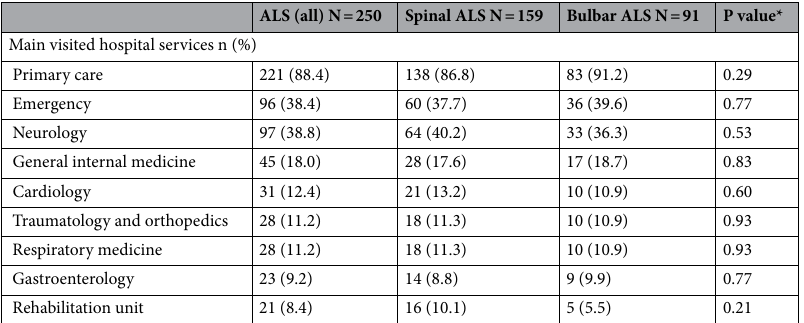
Table 2. Visited hospital departments and prior to ALS diagnosis. Pre-diagnosis analyses were performed using a window of [− 3 years, − 3 months) around diagnosis date. *Statistically significant differences between spinal and bulbar ALS were calculated using Pearson’s chi-squared tests for categorical variables and t-statistic tests for numeric variables.